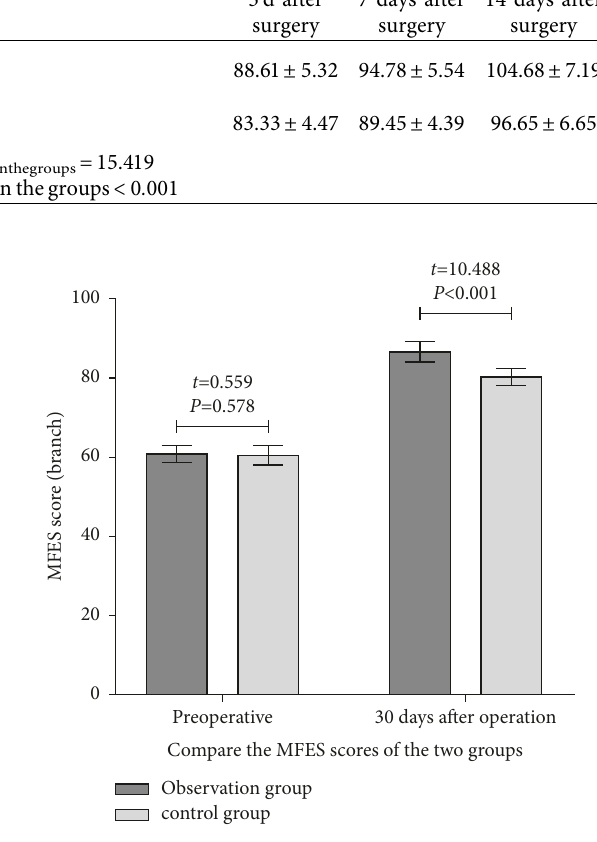
Figure 3: Comparison of the MFES scores between the two